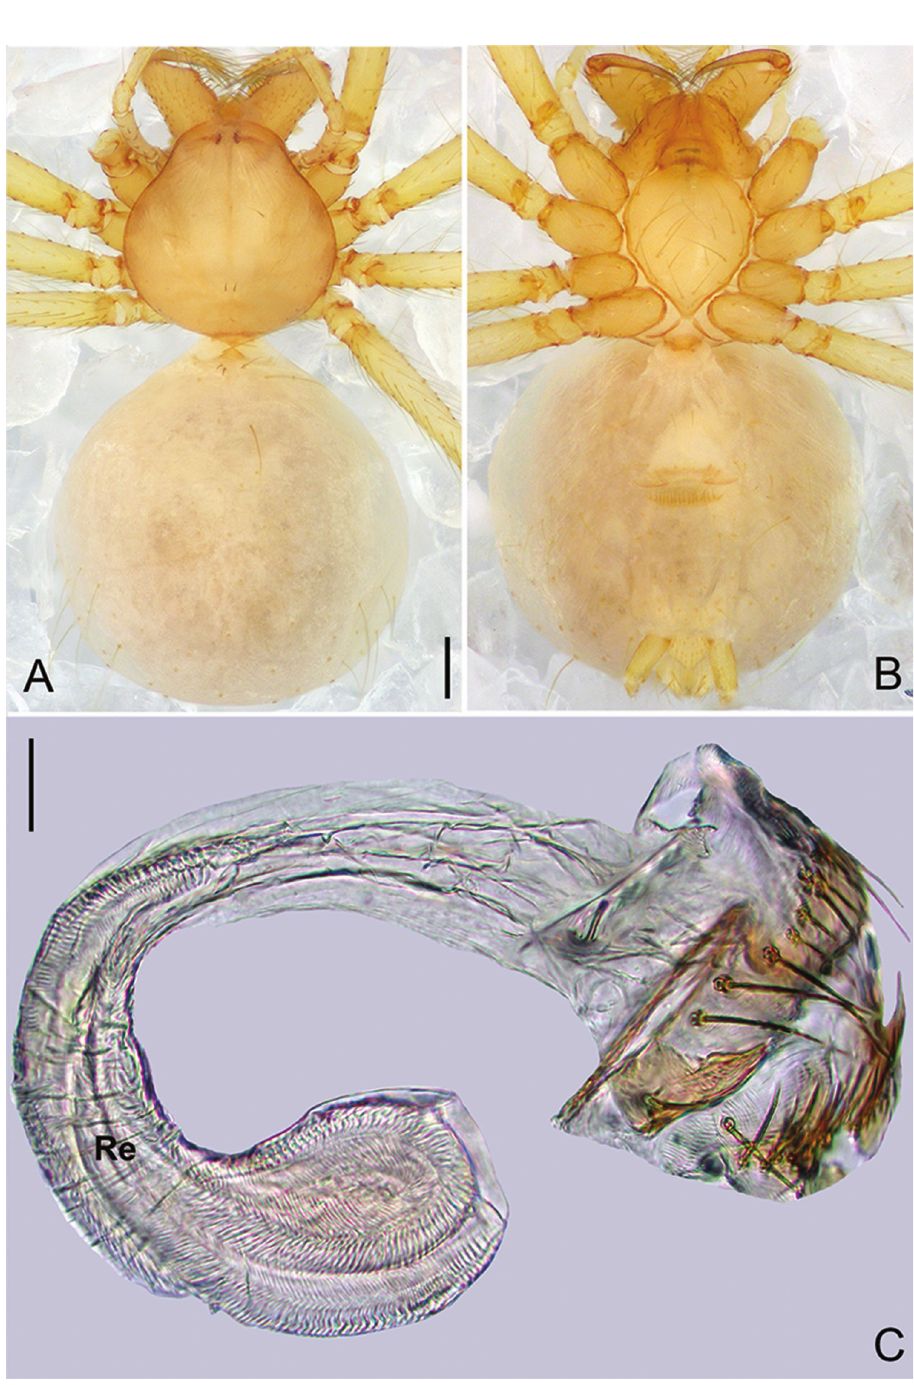
Figure 17. Pinelema strentarsi , female. A Habitus, dorsal view B Habitus, ventral view C Endogyne, lateral view. Scale bars: 0.2 mm ( A–B ), 0.05 mm ( C